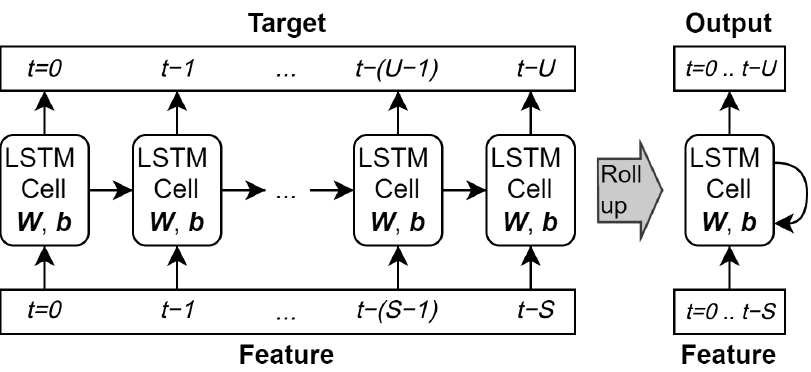
Figure 3. The feature sequence (length S ) is input to the LSTM cell chronologically, up to the most recent value at t = 0, and can be depicted “unrolled” (left) with the same cell multiple times, or “rolled up” showing one cell and the recurrent loop. In either case there is only one set of W -weights ( W xi , W hi , etc) and b -biases ( b i , b f , etc). Between time steps, the LSTM cell passes c and h to itself in the next time